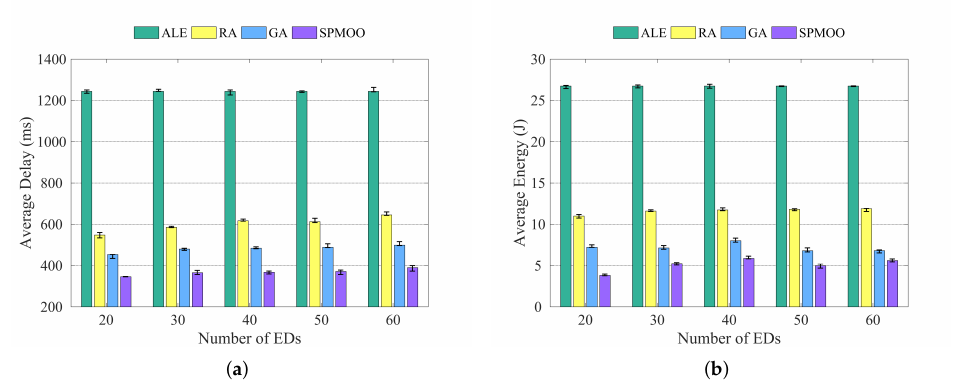
Figure 4. Comparison of the four algorithms when the number of end devices is {20, 30, 40, 50, 60}; ( a ) Average delay; ( b ) Average energy consumption.